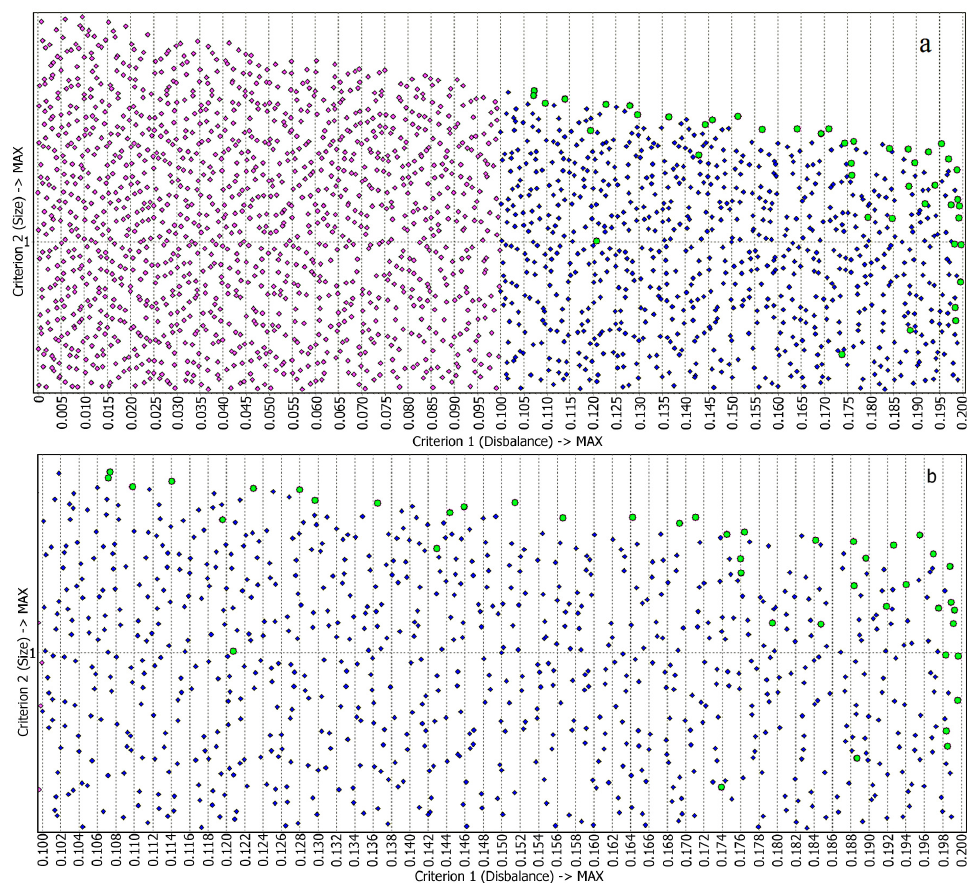
Figure 4. The set of solutions in the space of criteria: ( a ) K 1 and K 2 ; ( b ) K 1 and K 2 on a larger scale. Blue dots denote feasible solutions, crimson dots—infeasible ones due to the constraint K 1 > 0.1, green circles—Pareto optimal